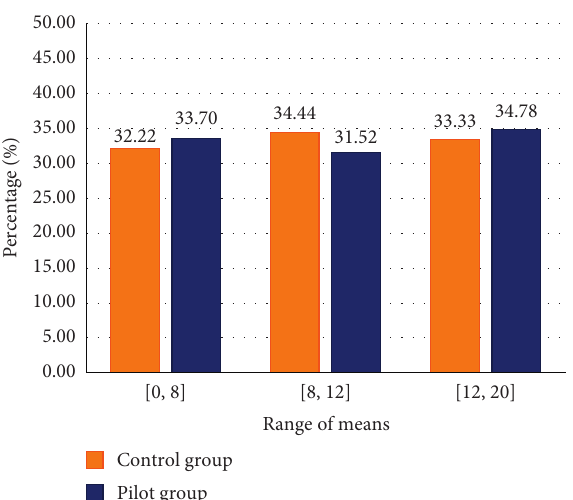
Figure 2: Distribution of means of diagnostic test results in the pilot and control groups. Table 6: Mann–Whitney test for independent samples (pretest) according to the method, gender, and area. Pretest according to the method used Pretest by gender Pretest according to the